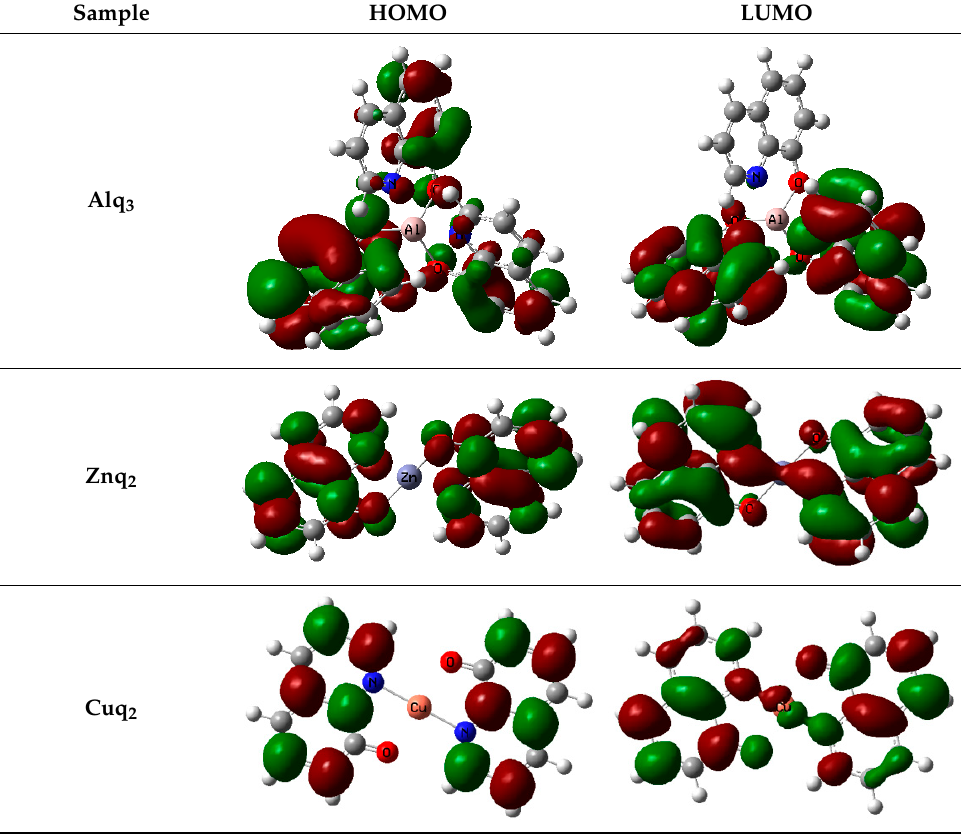
Table 4. The frontier molecular orbitals: HOMO and LUMO for Alq 3 , Znq 2 , and Cuq 2 . Sample